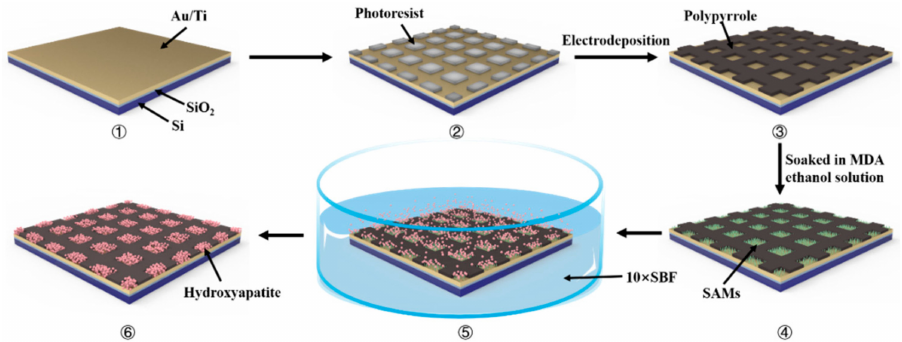
Figure 1. Fabrication process of micropatterned PPy coatings and micropatterned PPy/HA composite coatings. 1 (cid:13) The Au/Ti/Si wafer; 2 (cid:13) Micropatterned photoresist substrate; 3 (cid:13) The micropatterned PPy; 4 (cid:13) SAM-modified micropatterned PPy coatings; 5 (cid:13) The SAM-modified micropatterned PPy coatings soaked in 10 × SBF solution; 6 (cid:13) The micropatterned PPy/HA composite